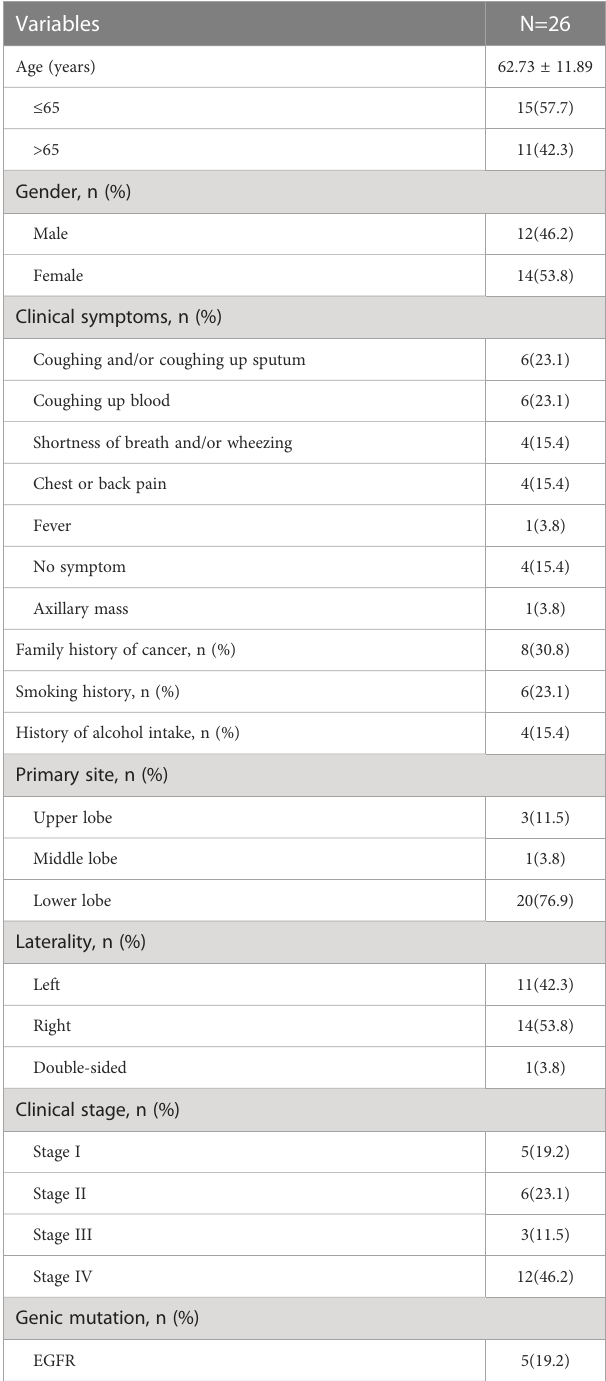
TABLE 1 Clinical characteristics of 26 patients from